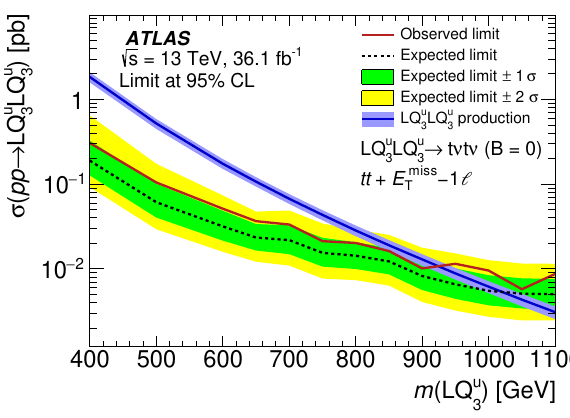
Figure 10 . Observed and expected 95% CL upper limit on the cross-section for up-type LQ pair production with B = 0 as a function of the LQ mass. The (cid:6) 1(2) (cid:27) uncertainty bands around the expected limit represent all sources of statistical and systematic uncertainties. The thickness of the theory curve represents the theoretical uncertainty from PDFs, renormalization and factorization scales, and the strong coupling constant (cid:11) s .